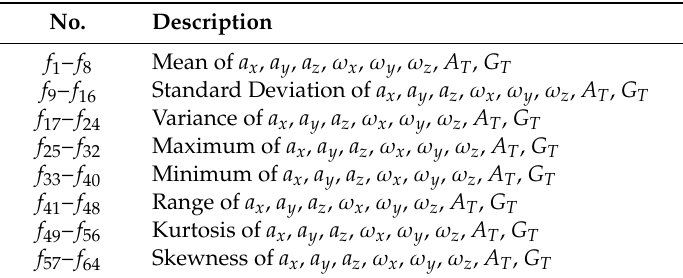
Table 1. List of the extracted